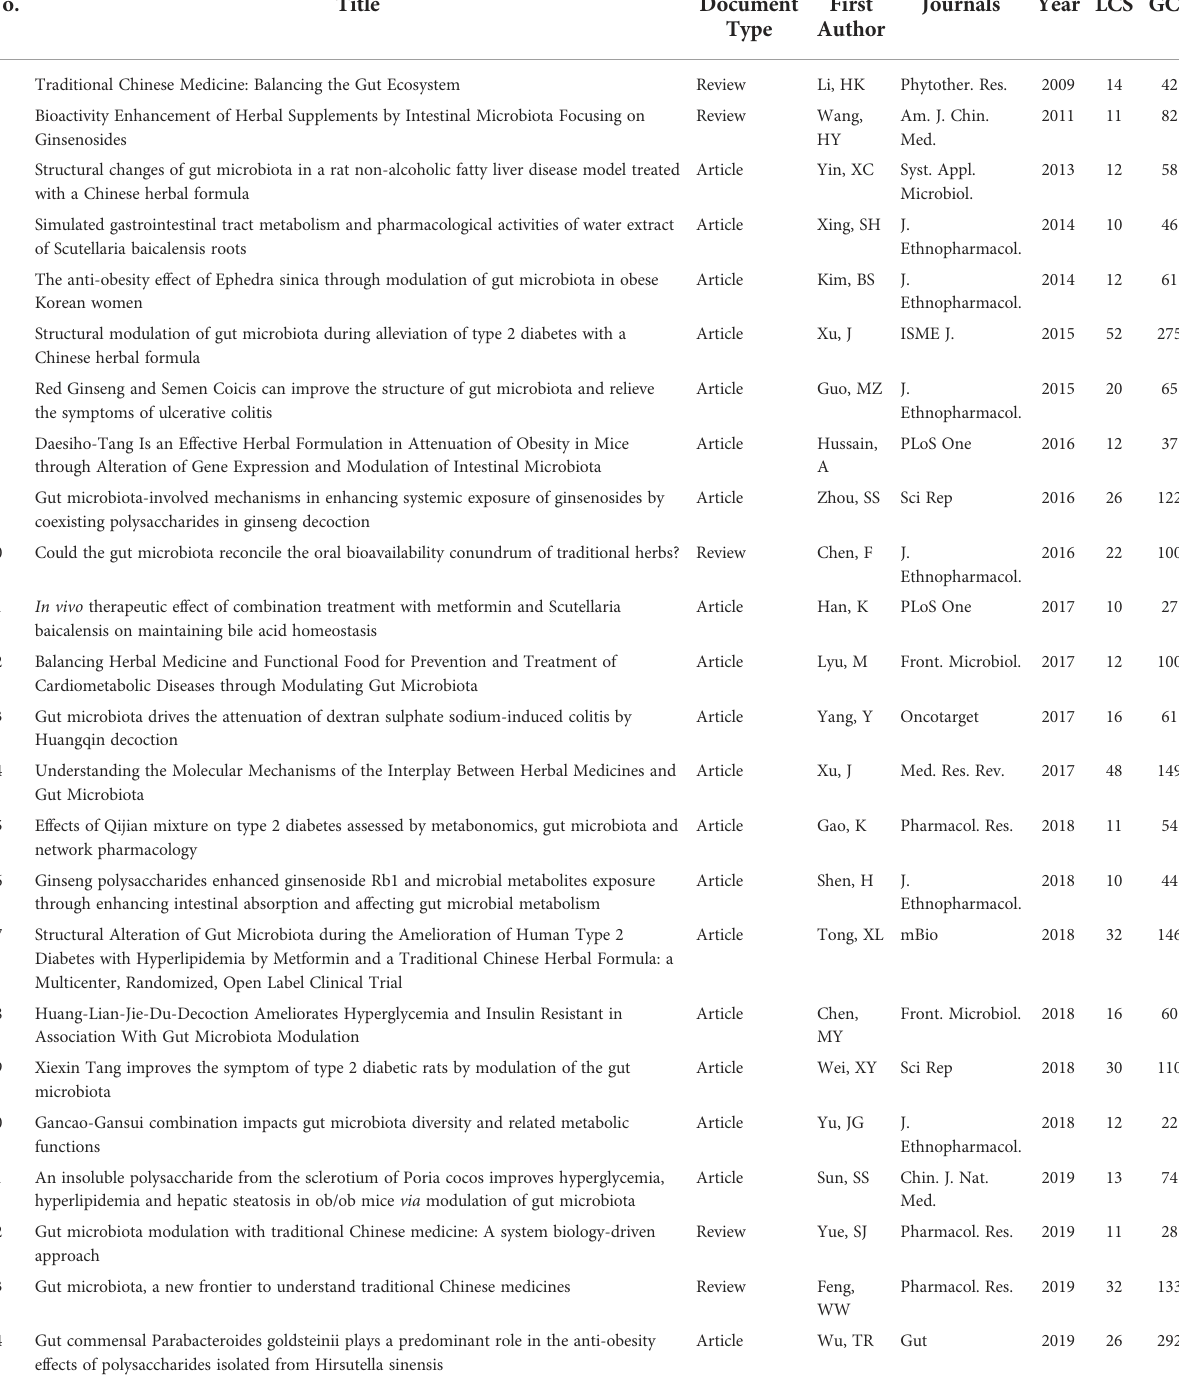
TABLE 5 The papers of historical direct citation network in the TCM/GM.